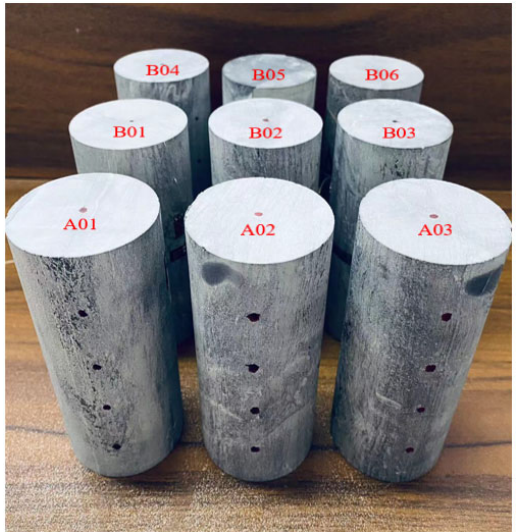
Figure 2. Rock samples. Figure 2. Rock Table 1. Basic parameters of test rock samples.